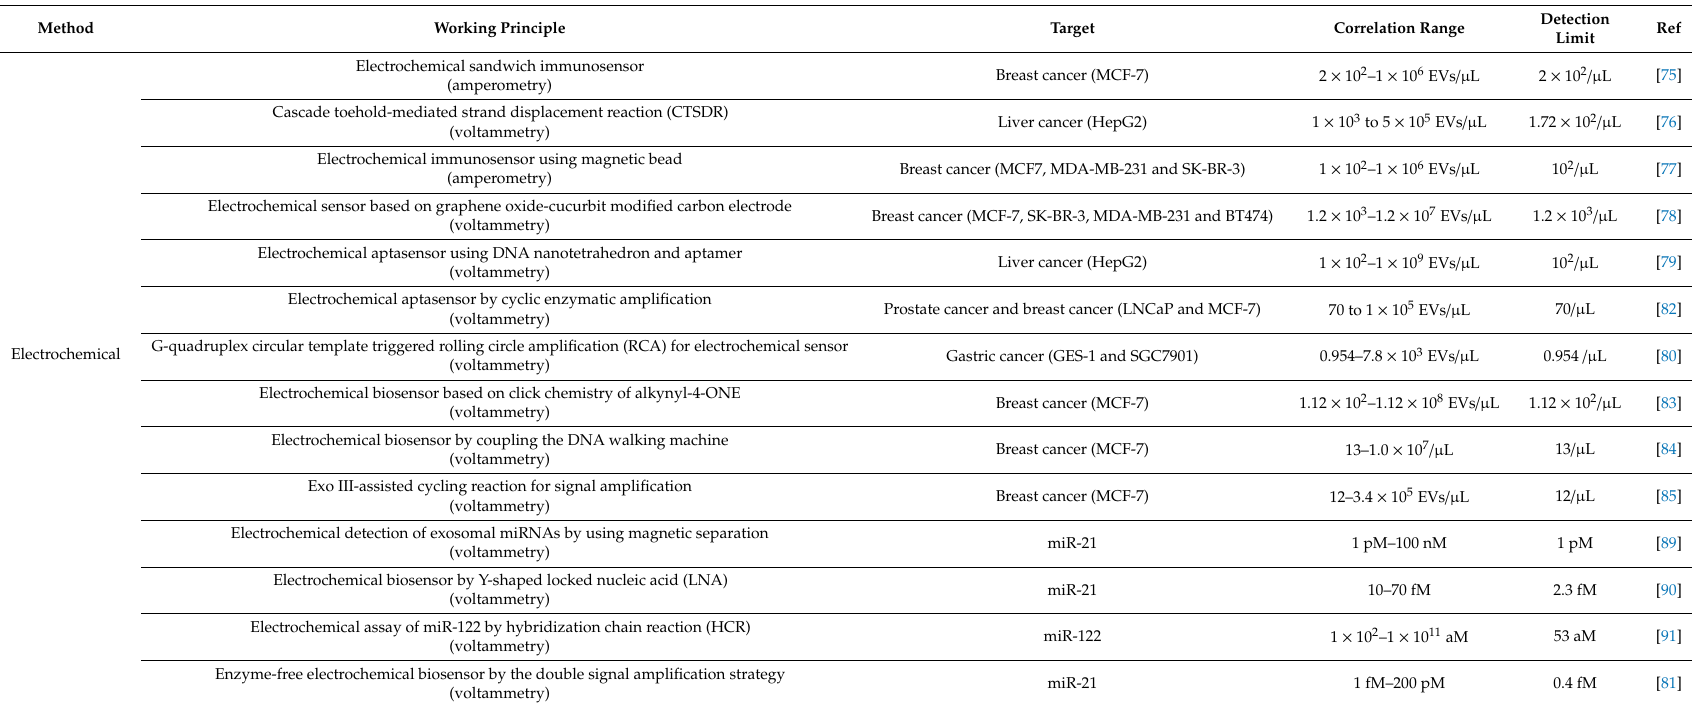
Table 3. Comparison of Electrochemical Bionano Sensors for EV